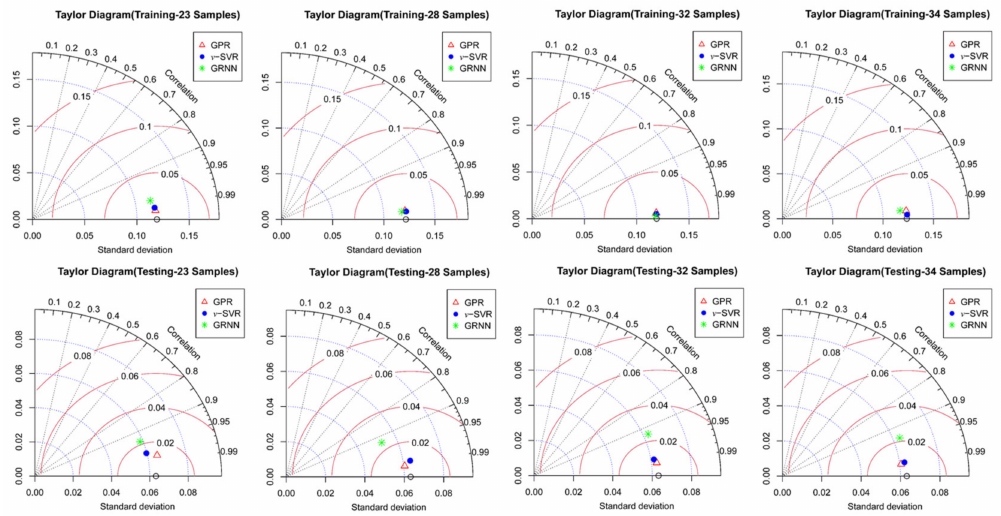
Figure 14. Taylor Diagram of training and testing obtained from WOA-GPR, v -SVR, and GRNN.